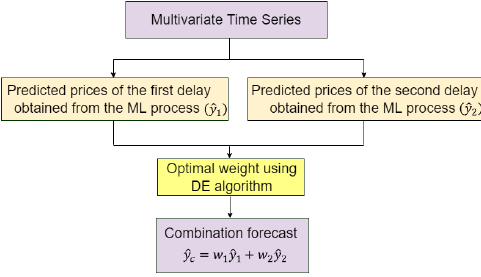
Figure 6. The two-delay hybrid